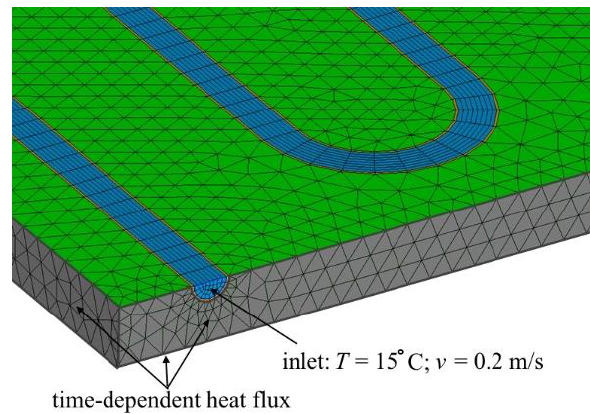
Fig. 4. Fragment of 3D finite element